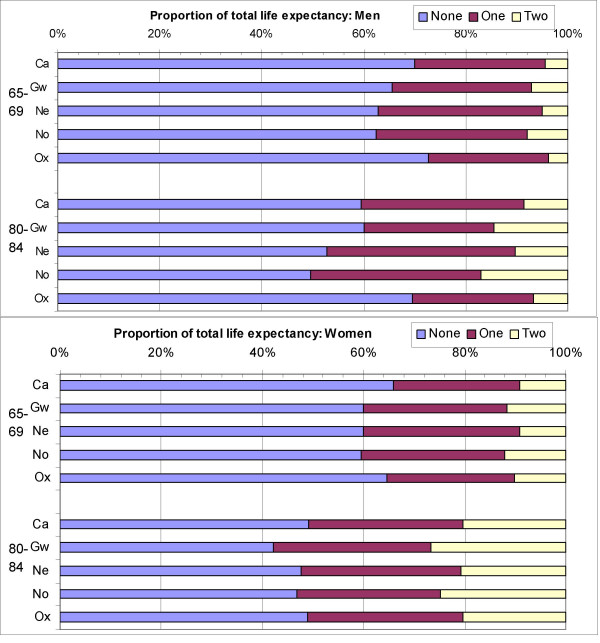
Proportion of life spent by number of impairments for ages 65–69 and 80–84 years and by centre.